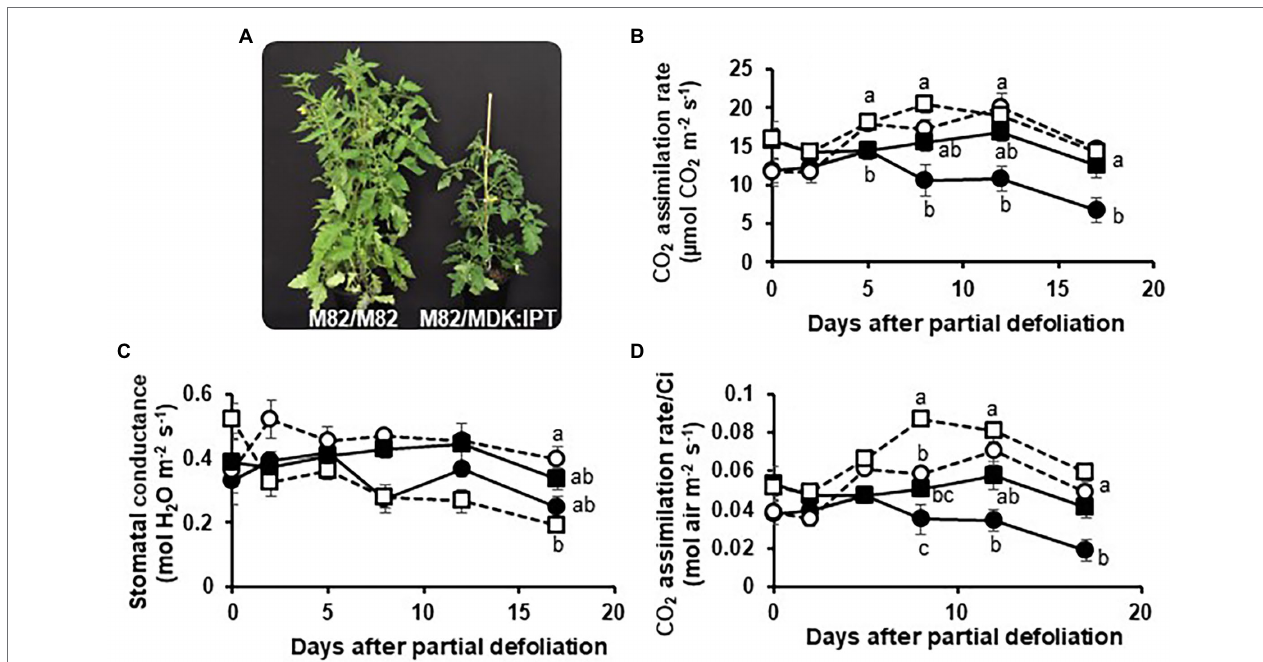
FIGURE 4 | Enhanced cytokinin biosynthesis in the roots delays leaf senescence in grafted plants. Picture of the homografted M82/M82 (left) and heterografted M82 scions over MDK:IPT rootstocks (right; A ), photosynthetic rate (B) , stomatal conductance (C) , and the rate of photosynthesis per internal CO 2 concentration (Ci; D ) of remaining tomato leaves after partial defoliation of the other leaves (empty symbols). Defoliation was performed on either homografted (circles) or heterografted (squares) plants grown in a temperature-controlled greenhouse (25 ° C/18 ° C day/night). Dashed lines and empty symbols represent partially defoliated plants; solid lines and full symbols represent nondefoliated plants. Student’s t -test was used to compare mean values of six plants. Different letters indicate significant differences at p < 0.05.